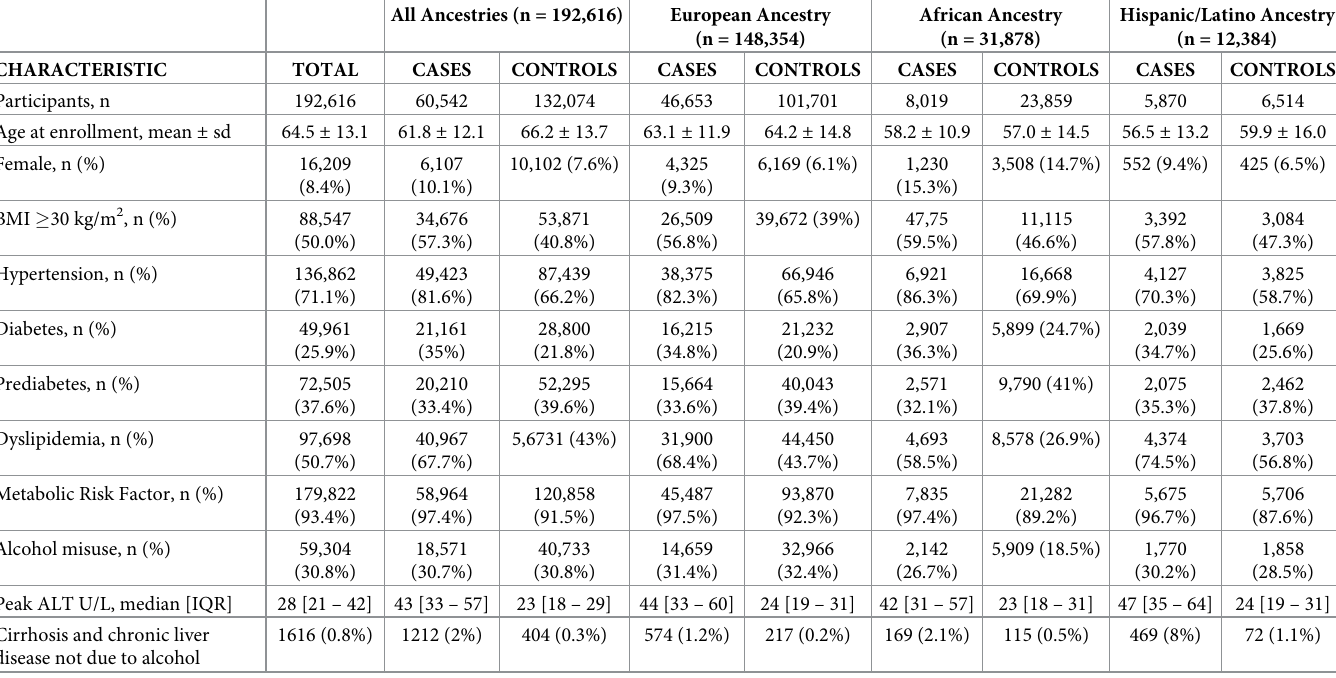
Table 1. Baseline characteristics of the MVP NAFLD analytic cohort defined by the ALT-threshold definition.